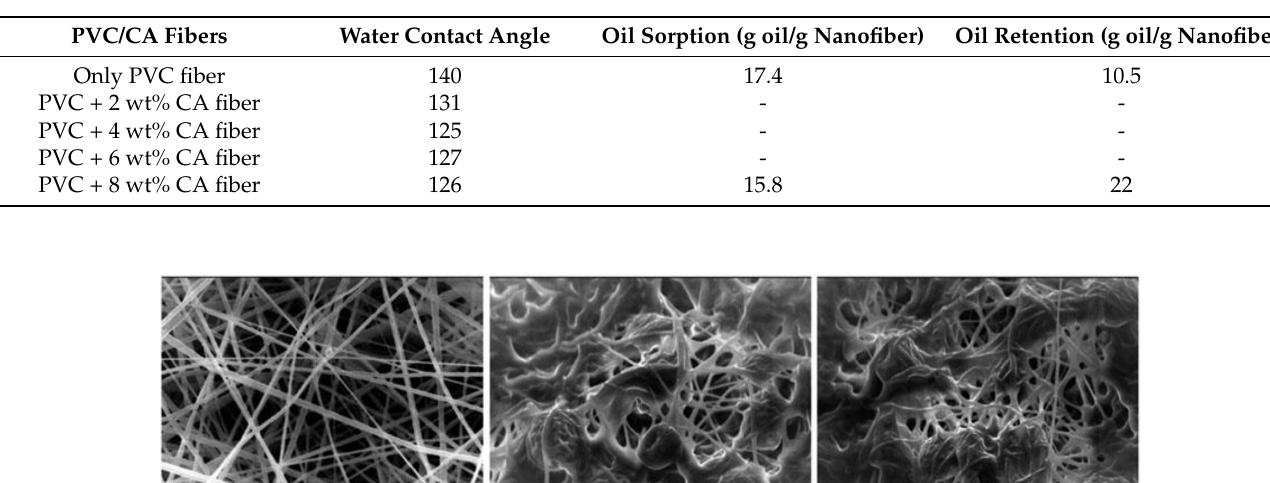
Table 9. Water contact angle and an oil absorption of the PVC nanofiber mats [74].